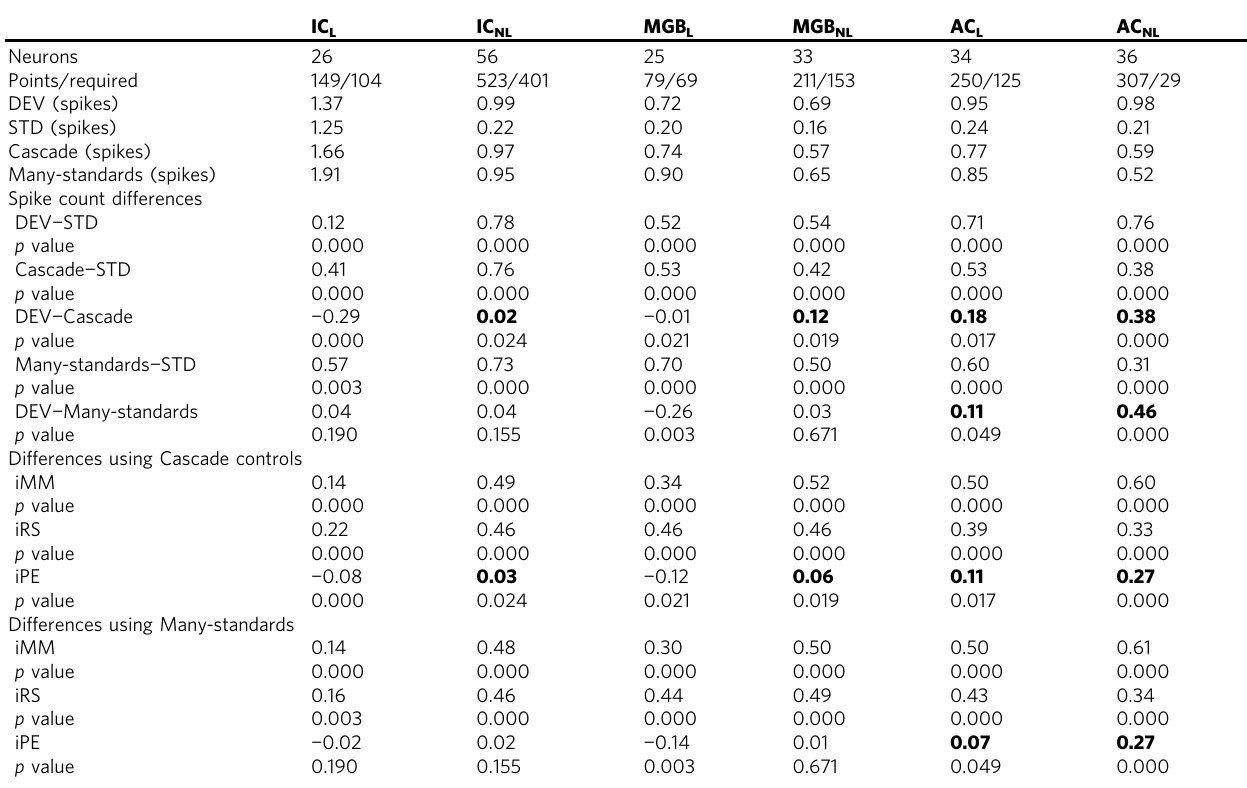
Table 1 Summary of principal urethane data